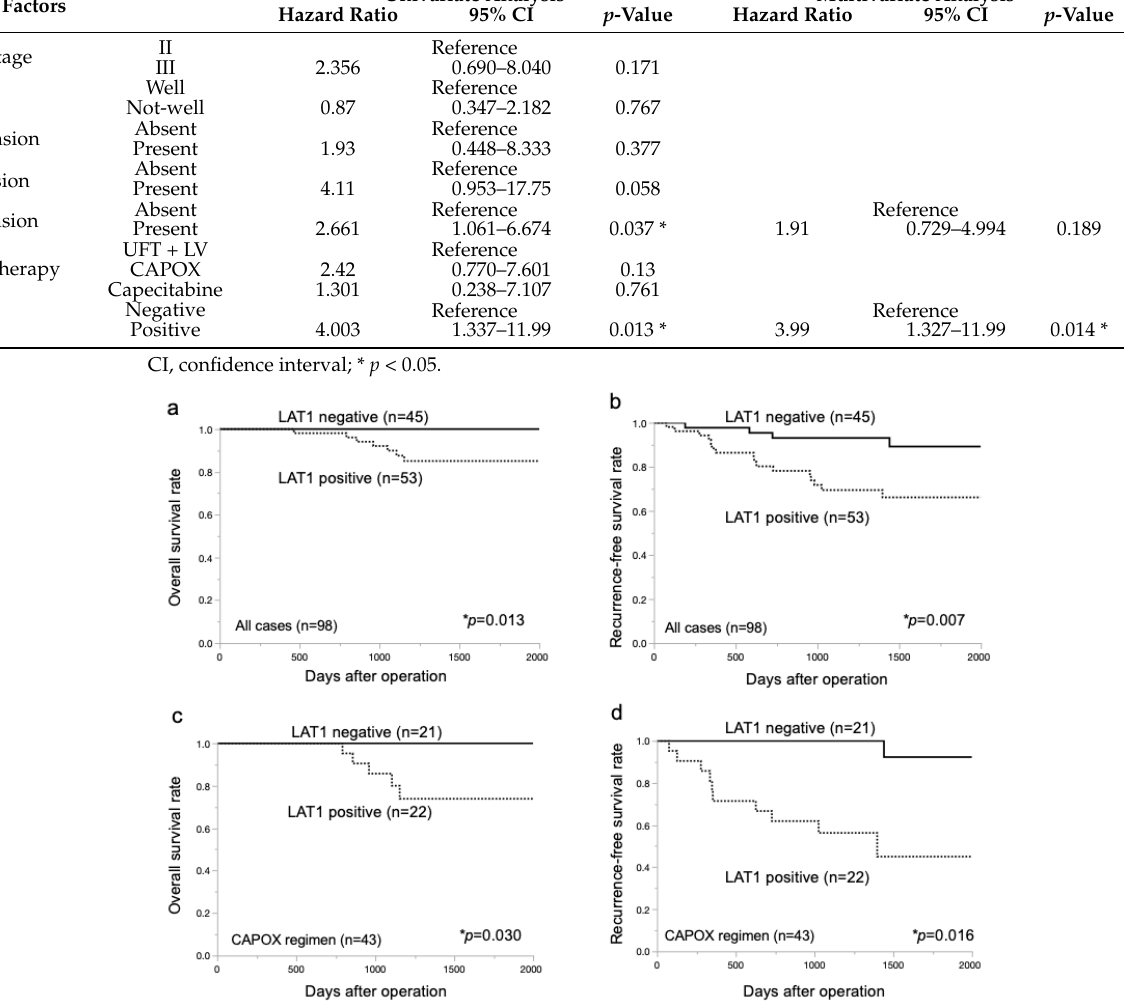
Figure 2. Kaplan–Meier survival curves of patients with CRC according to LAT1 expression. ( a , b ) Kaplan–Meier analysis of overall and recurrence-free survival in 98 CRC patients treated by adjuvant chemotherapy ( p = 0.013 and p = 0.007, respectively). The analyses were based on LAT1 expression. ( c , d ) Kaplan–Meier analyses of overall survival and recurrence-free survival in 43 CRC patients treated with CAPOX regimen, including oxaliplatin, according to LAT1 expression ( p = 0.03 and p = 0.016, respectively).